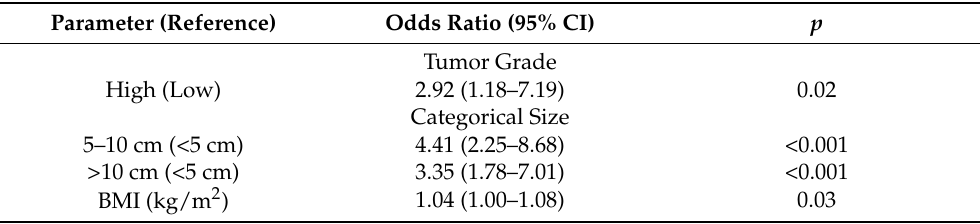
Table 5. Odds ratio estimates with 95% confidence intervals and p -value from the multivariate model on pulmonary